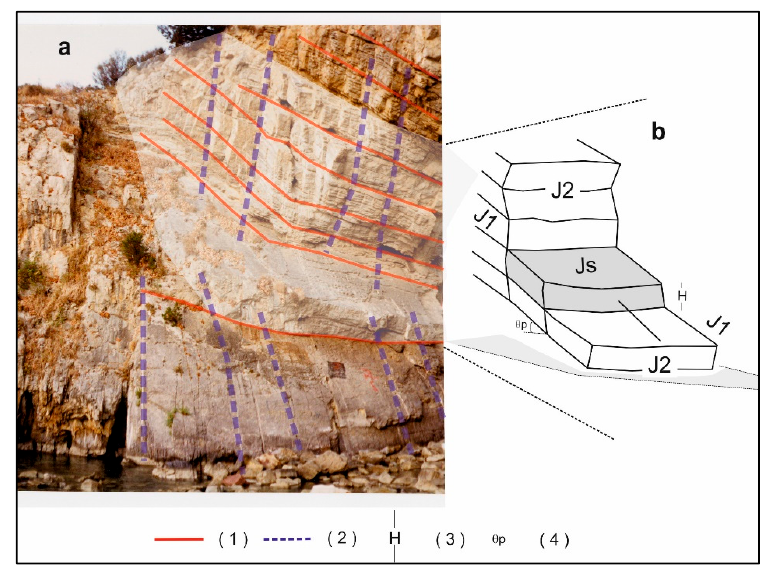
Figure 5. ( a ) View of the slope where blocks are potentially prone to plane failures; ( b ) geometrical model adopted in calculations. Key: (1) discontinuity belonging to the Js joint set; (2) discontinuity belonging to the J1 joint set; (3) block height; (4) dip angle of the Js joint set. Geosciences 2019 , 9 , x FOR PEER REVIEW The rock mass is affected by three main joint sets which group the bedding planes (Js joint set) as well as tectonic discontinuities with different orientation (J1 and J2 joint sets). Bedding planes, with